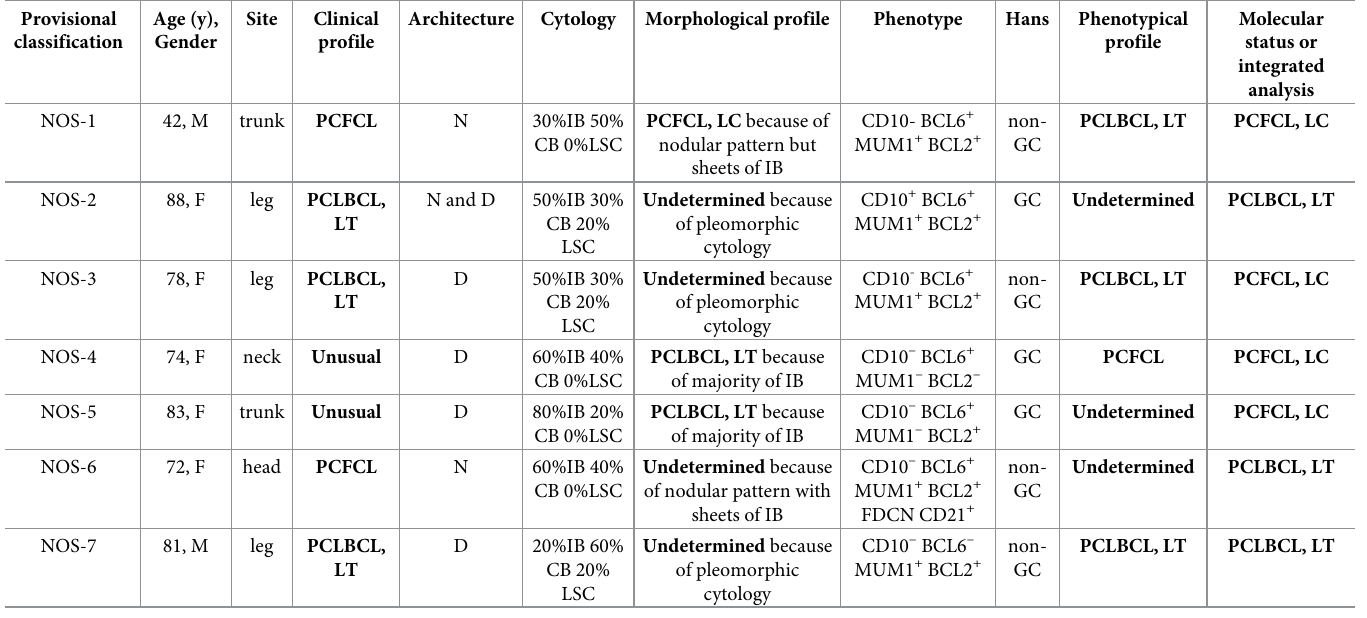
Table 1. Clinical presentation, morphology, phenotype, molecular profile and outcome of the 7 primary cutaneous large B-cell lymphomas not otherwise specified cases. Provisional